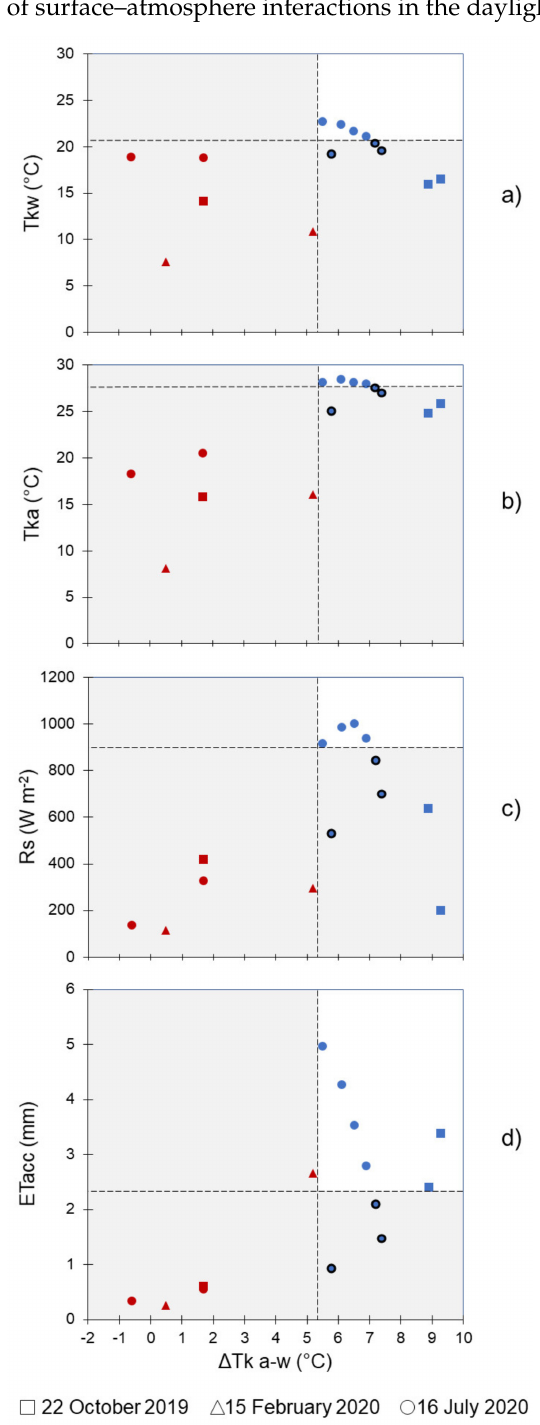
Figure 7. For each of the 14 flights performed, several variables are shown against the thermal con- trasts between water and air ( ∆ Tk a–w): ( a ) kinetic temperature of air (Tka); ( b ) kinetic